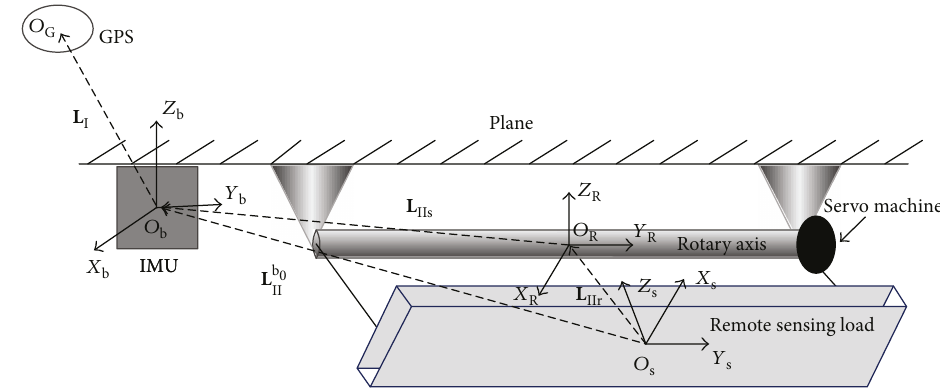
Figure 2: The fi rst-level dynamic lever arm mechanism.